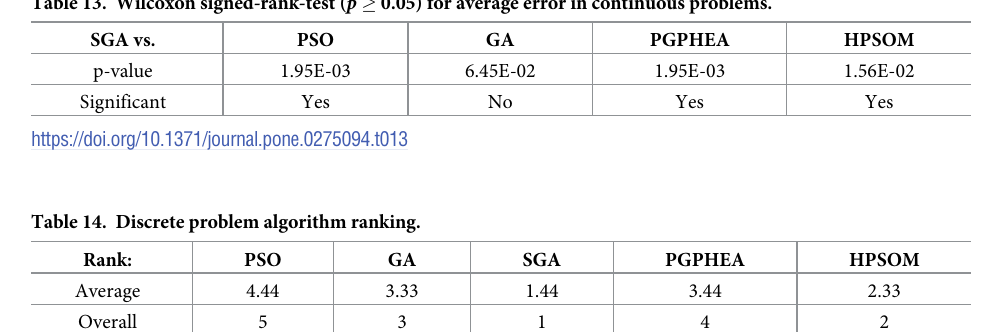
(traveling salesman) benchmark problems were examined and comparisons were made against GA, PSO and two existing hybrid algorithms. The results showed that SGA has in overall sig- nificantly better performance than PSO and GA in terms of accuracy, in both continuous and discrete problems.